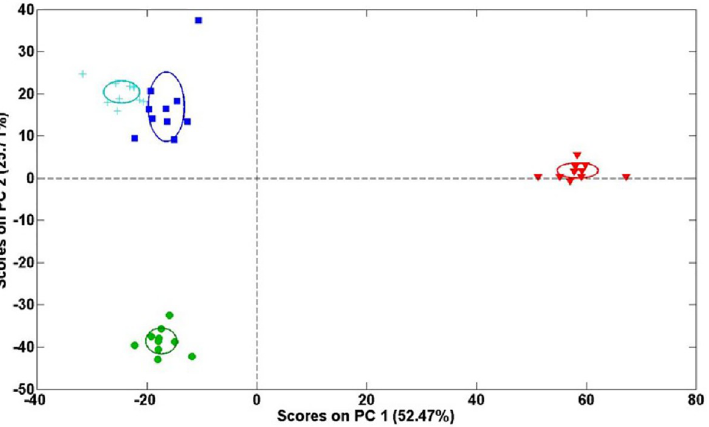
Fig 3. Score plots of Principal Component Analysis (PCA) of metabolite profiles from Jerusalem artichoke. Untreated (light blue cross) and treated with 150 mM NaCl for 1 day (blue square), 3 days (green circle) and 7days (red inverted triangle). Each sample of different groups presented by a single data point. PC1 and PC2 covering 78.18% of the variance. The variable salt treatment contributions for the clustering of metabolite samples.